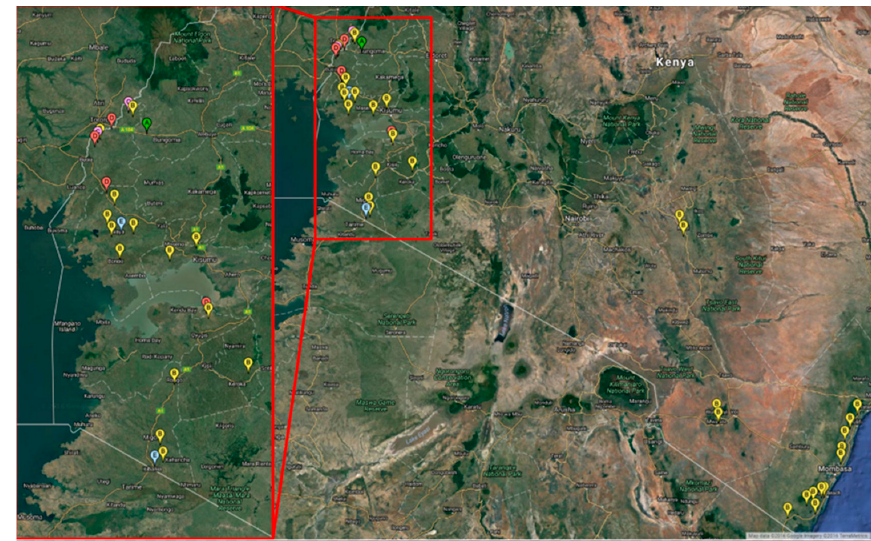
Figure 2. Map of Kenya showing distribution of cassava whiteflies included in this study. The red box highlights the collection sites near Lake Victoria, and the red box to the left is a blow-up of that region. The different coloured circles with letters represent the five different clades Bemisia tabaci species (A–E or SSA-A–E) as indicated in Table 1 in the column labelled “Genetic Group”.